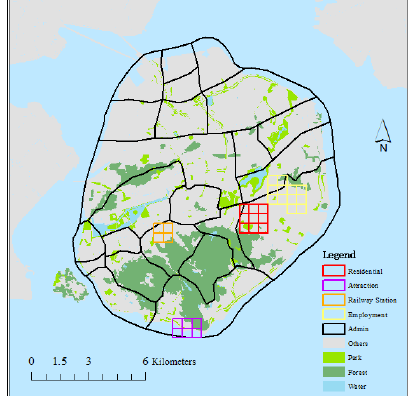
Figure 12. Location of four representative regions.